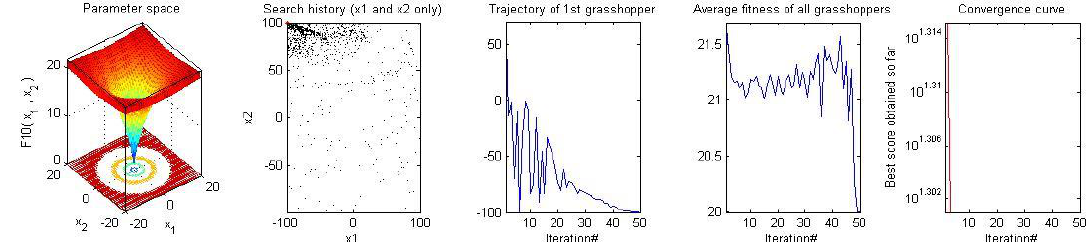
Figure 11. HAGOA behavior on multimodal function (F10)